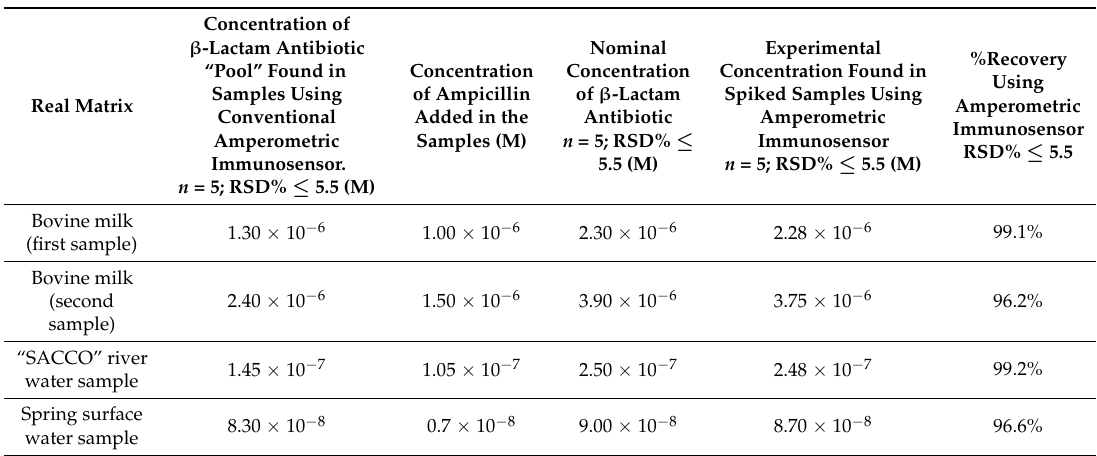
Table 6. Recovery tests for ampicillin using the conventional amperometric immunosensor in real samples of bovine milk and river and spring surface water samples; values expressed as M (of